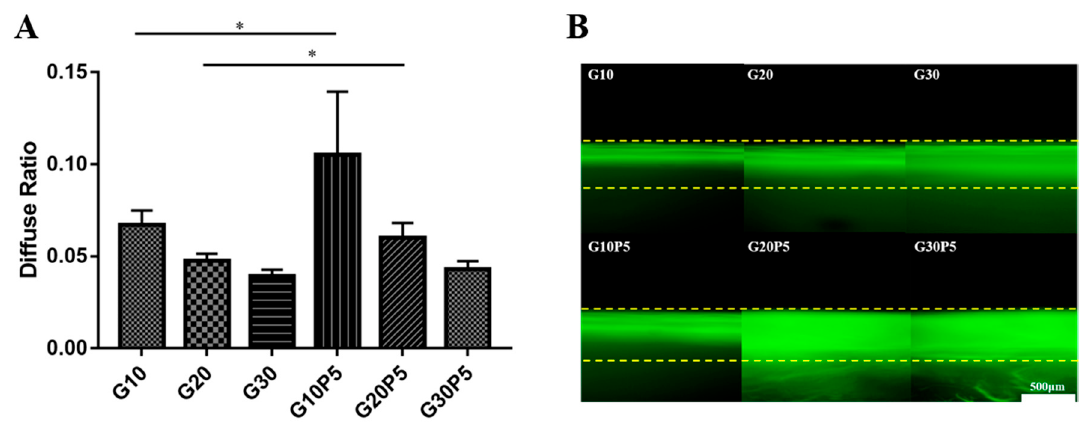
Figure 4. ( A ) The diffusion coefficient of water for 1 h; ( B ) the FITC-BSA one-dimensional diffusion in hydrogel (* P < 0.05).